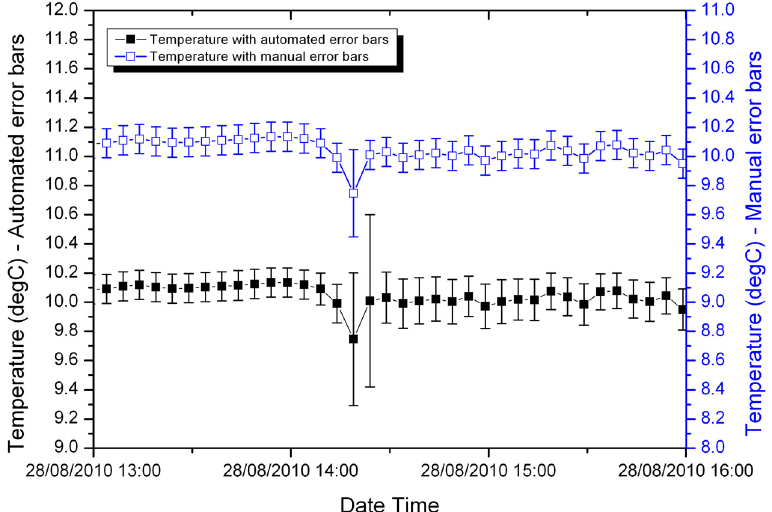
Figure 4. Shallow water temperature with manually calculated and automatically generated error bars for a period early in the sensor